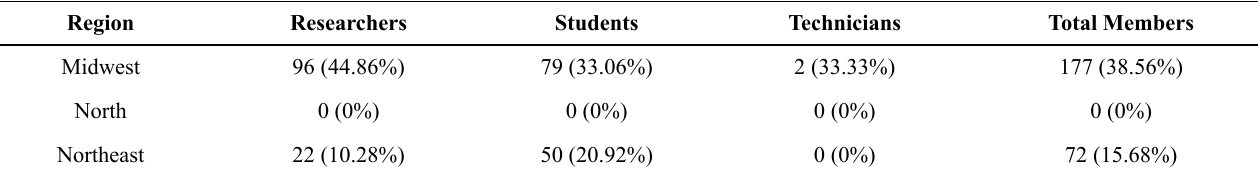
Table 1. Number and percentage of members of the research groups on diet and exercise interventions in cancer, by category, in January 2017 Region Researchers Students Midwest